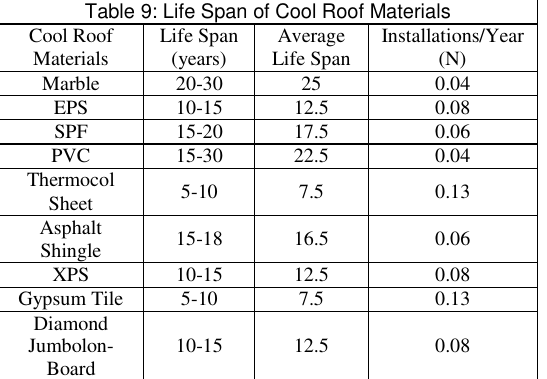
Table 9: Life Span of Cool Roof Materials Cool Roof